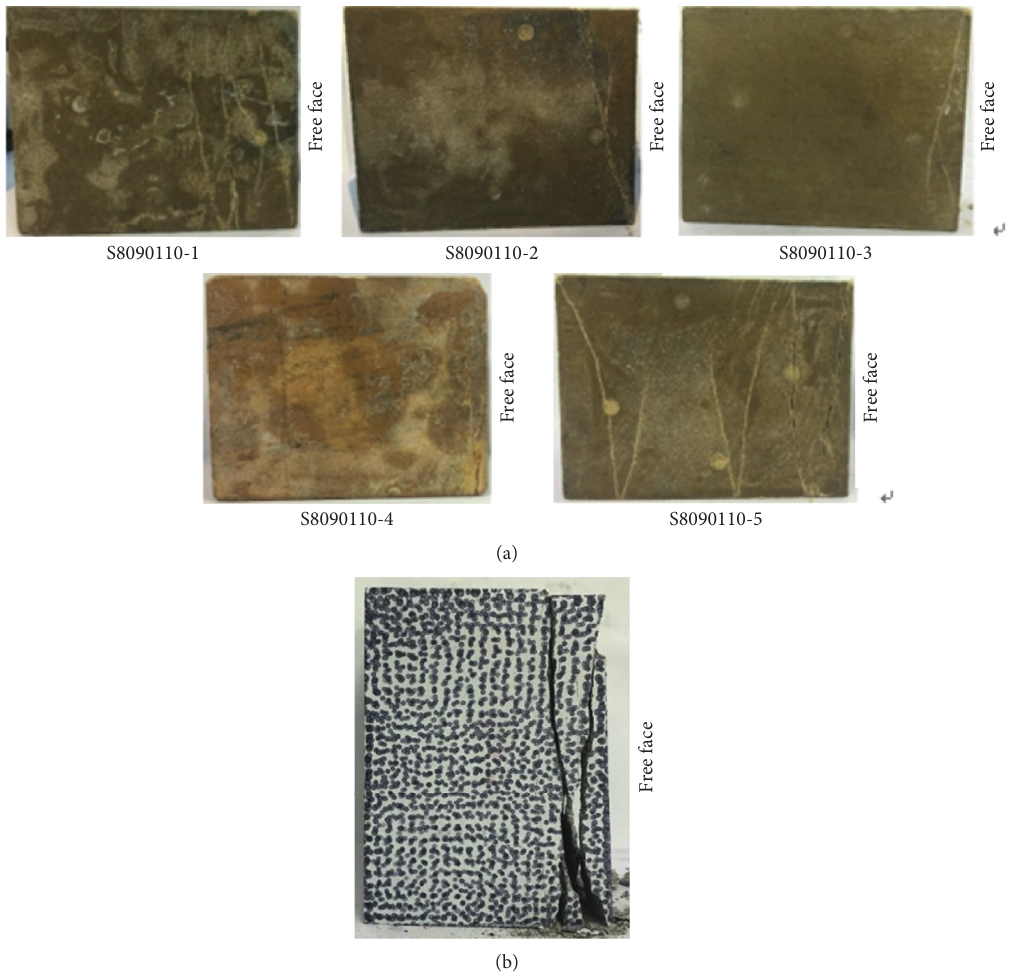
Figure 8: Damage images of samples. (a) Sandstone damage results. (b) Granite damage